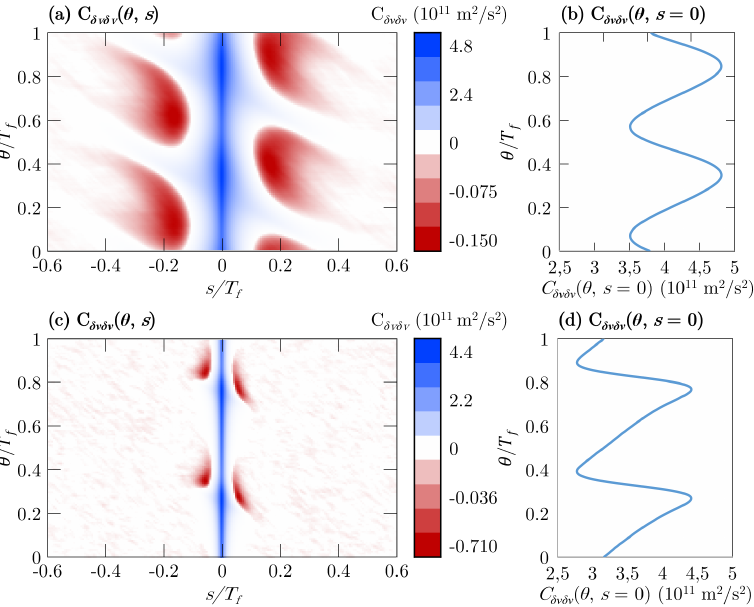
Figure 5. The transient correlation functions for graphene on h-BN 2 at ( a ) E AC = 2 and ( c ) 20 kV/cm. The corresponding correlations at s = 0 are also depicted at ( b , d